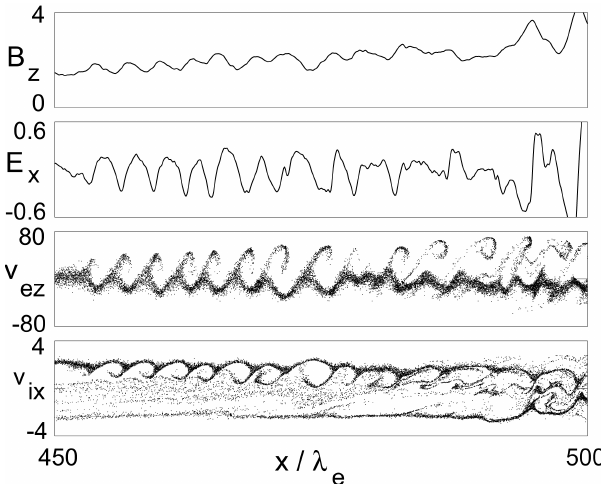
Fig. 7. From top to bottom: magnetic field B z component, ion den- sity n i , and ion v ix phase space versus shock normal direction x for the ion to electron mass ratio 1840 run at t(cid:127) ci = 3 . 7.